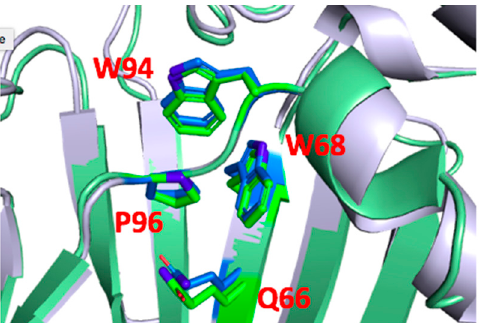
Figure 8. P96 faces the interior of the subunit ECD and its distance from Q66 differs slightly in the open (green) and closed (blue) GlyR structures.